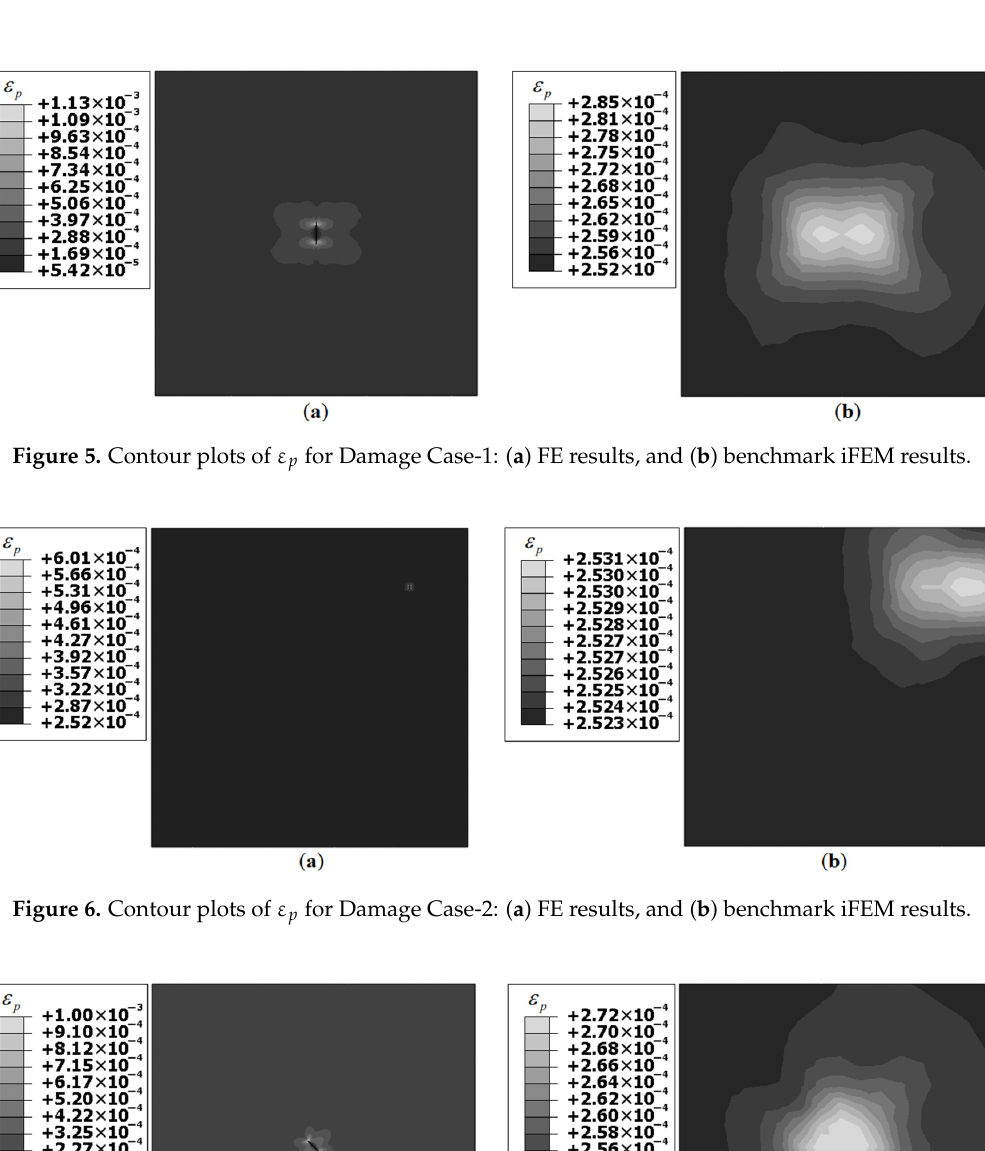
(cid:3043) . This is due to the absence of